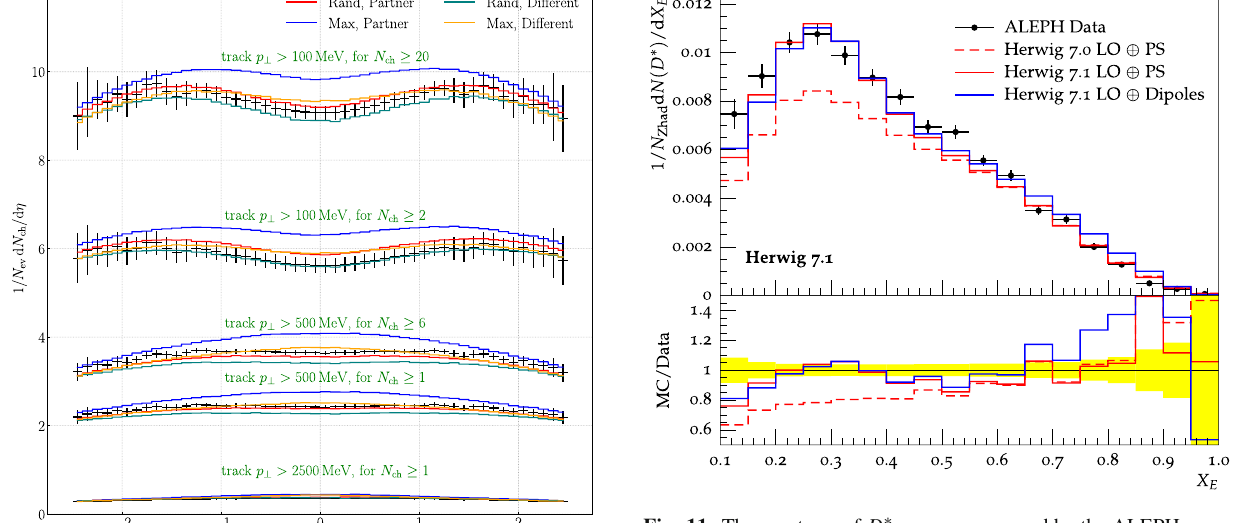
Fig. 11 The spectrum of D ∗ mesons measured by the ALEPH exper- iment [48] compared to Herwig . As an example, we show LO plus PS predictions, however as expected these are not significantly changed in the presence of higher order corrections 5